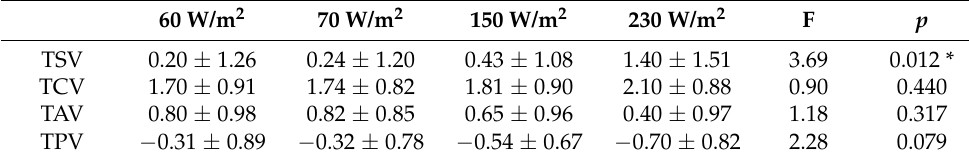
Table 10. Comparison of activity levels between groups.